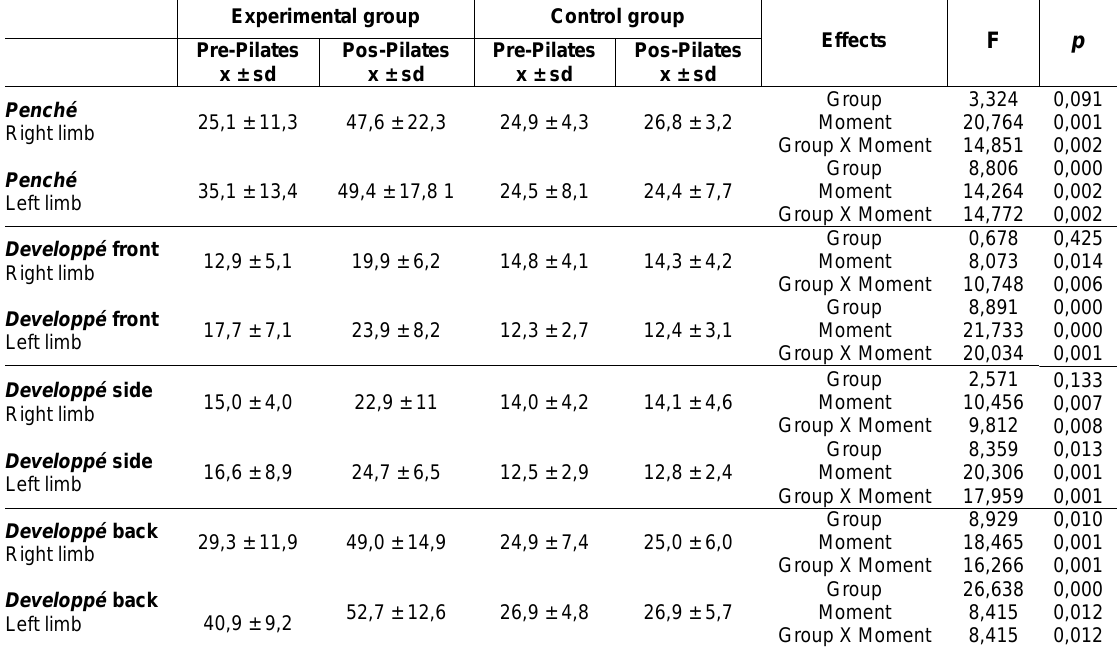
Table 1. Muscular strength measures (seconds) pre and post-Pilates training.